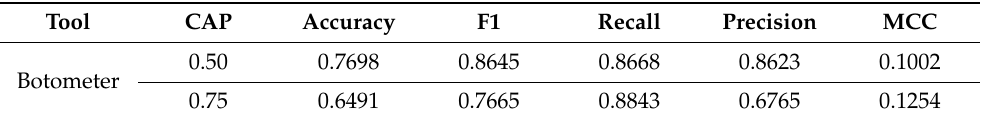
Table 4. Botometer results using group 1 dataset.